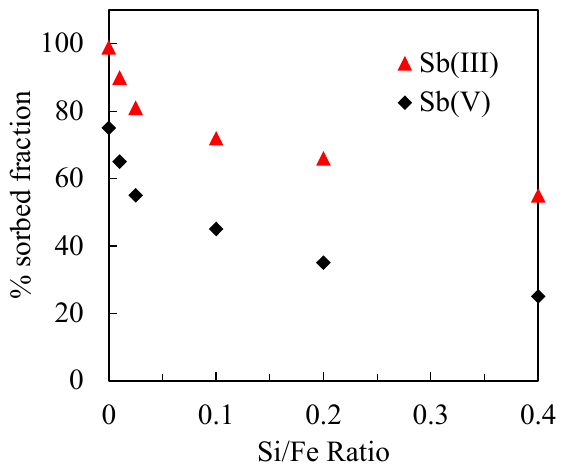
Figure 6. Adsorption of Sb(V) onto ferrihydrite with different Si/Fe ratios in 0.01 M NaCl solution at pH 7. The initial Sb(III) concentration were 100 µM. The concentrations of suspended solids were 0.5 g/L.